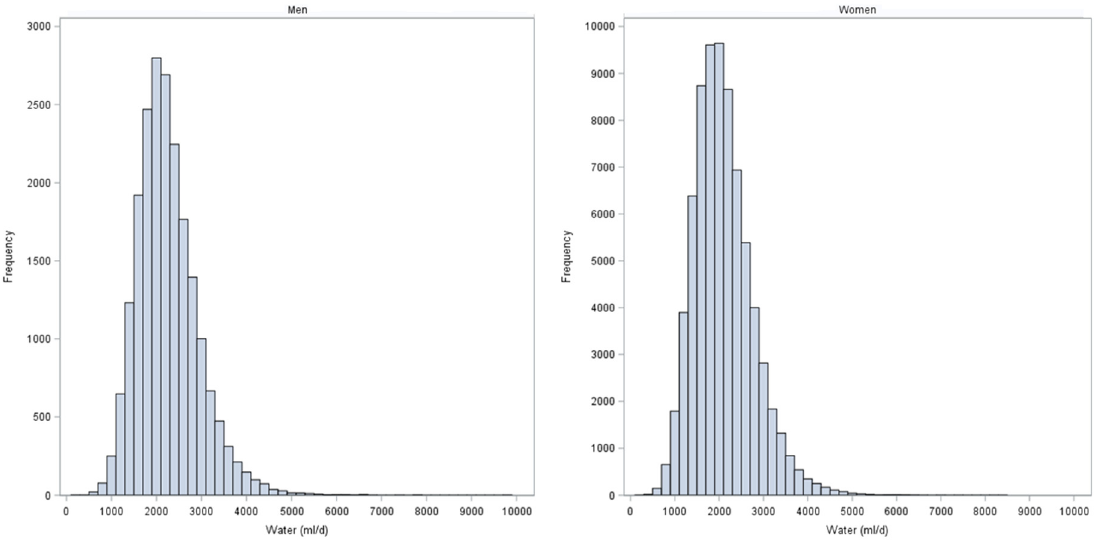
Figure 1. Frequency distribution of total water intake (mL/day) by gender. Table 1. Statistical description for the whole sample, and by gender.